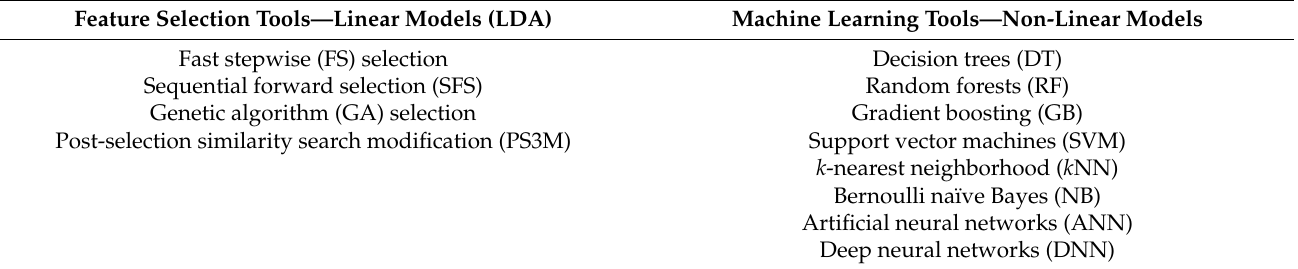
Table 2. Feature selection and machine learning tools used for moving average based multitasking modeling